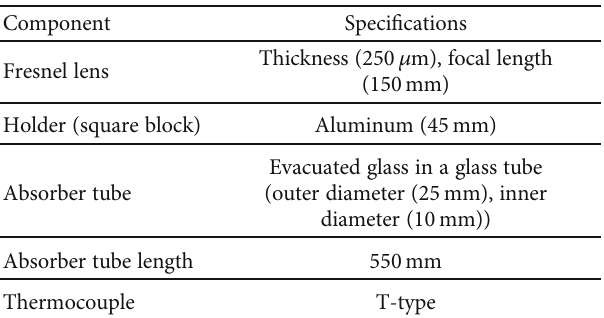
Figure 5: Photographic view of the experimental setup. Table 3: Speci fi cations of the experimental